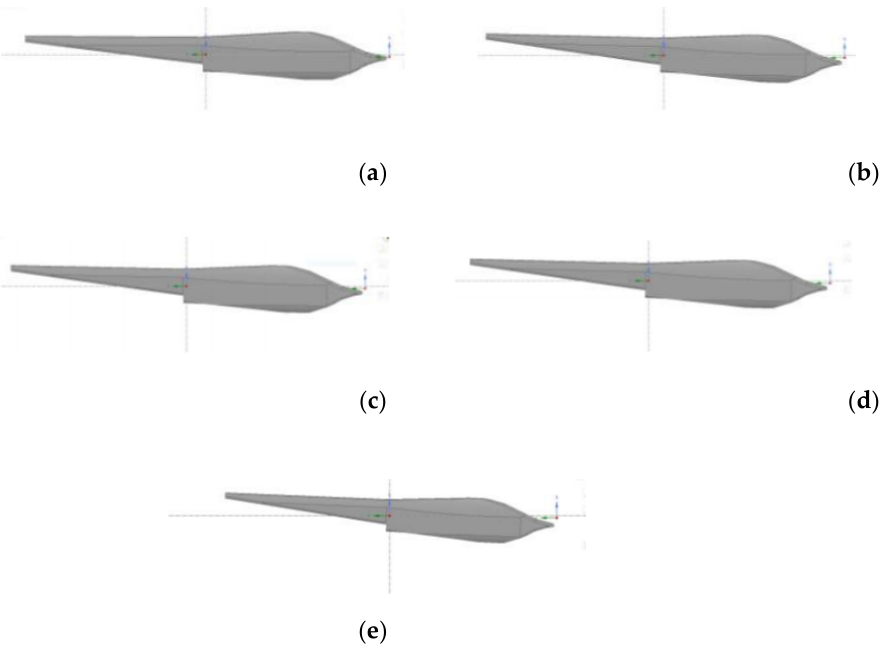
Figure 3. Initial Float with variations of bow trim: ( a ) 0.44 degree; ( b ) 0.88 degree; ( c ) 1.32 degree; ( d ) 1.76 degree; and ( e ) 2.2 degree.